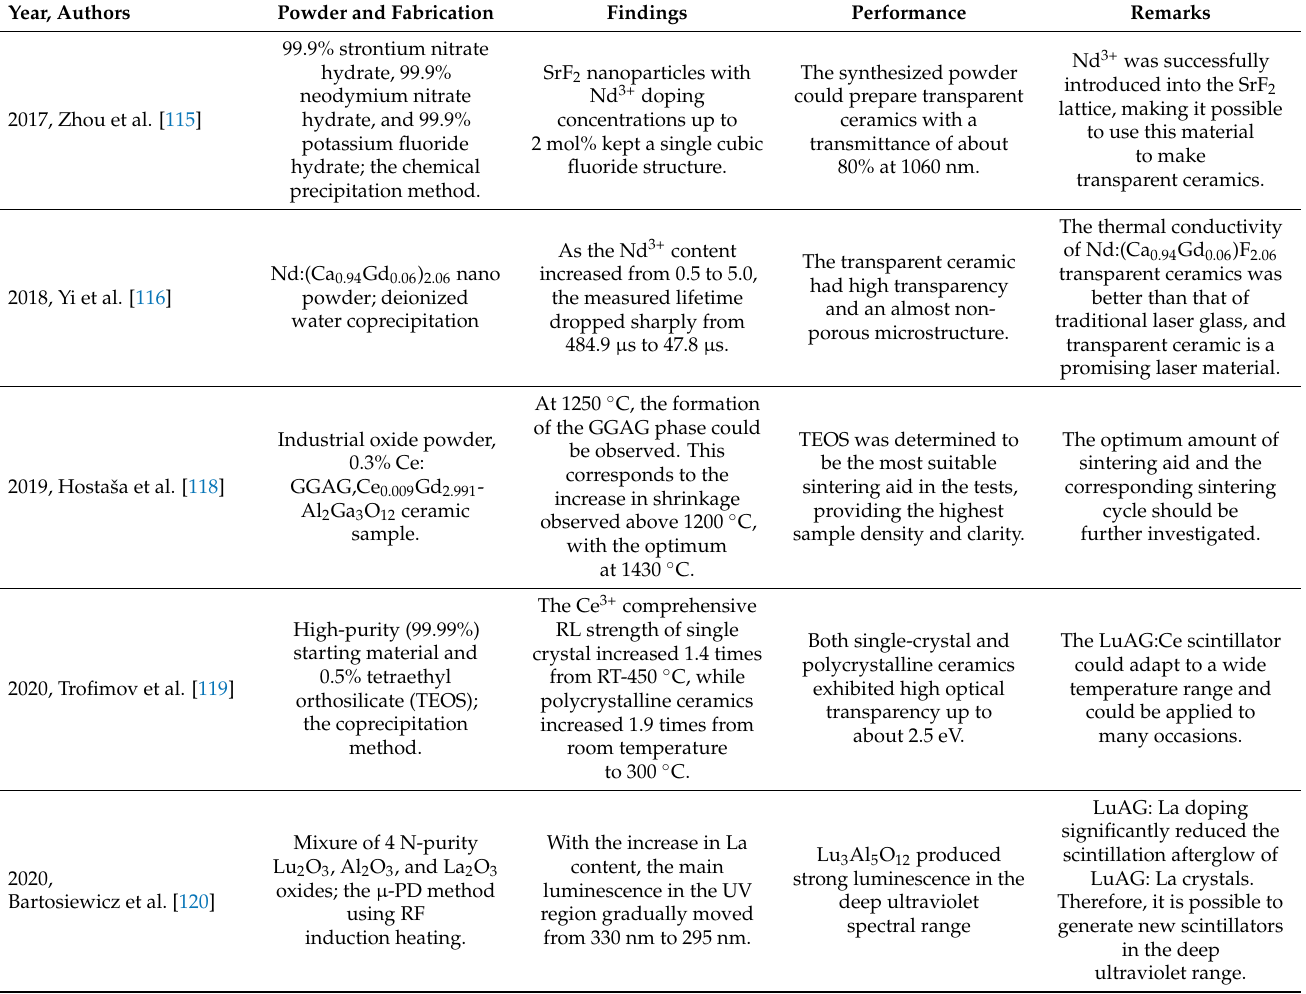
Table 4. Summary of scintillation transparent nano-ceramics described in the text grouped